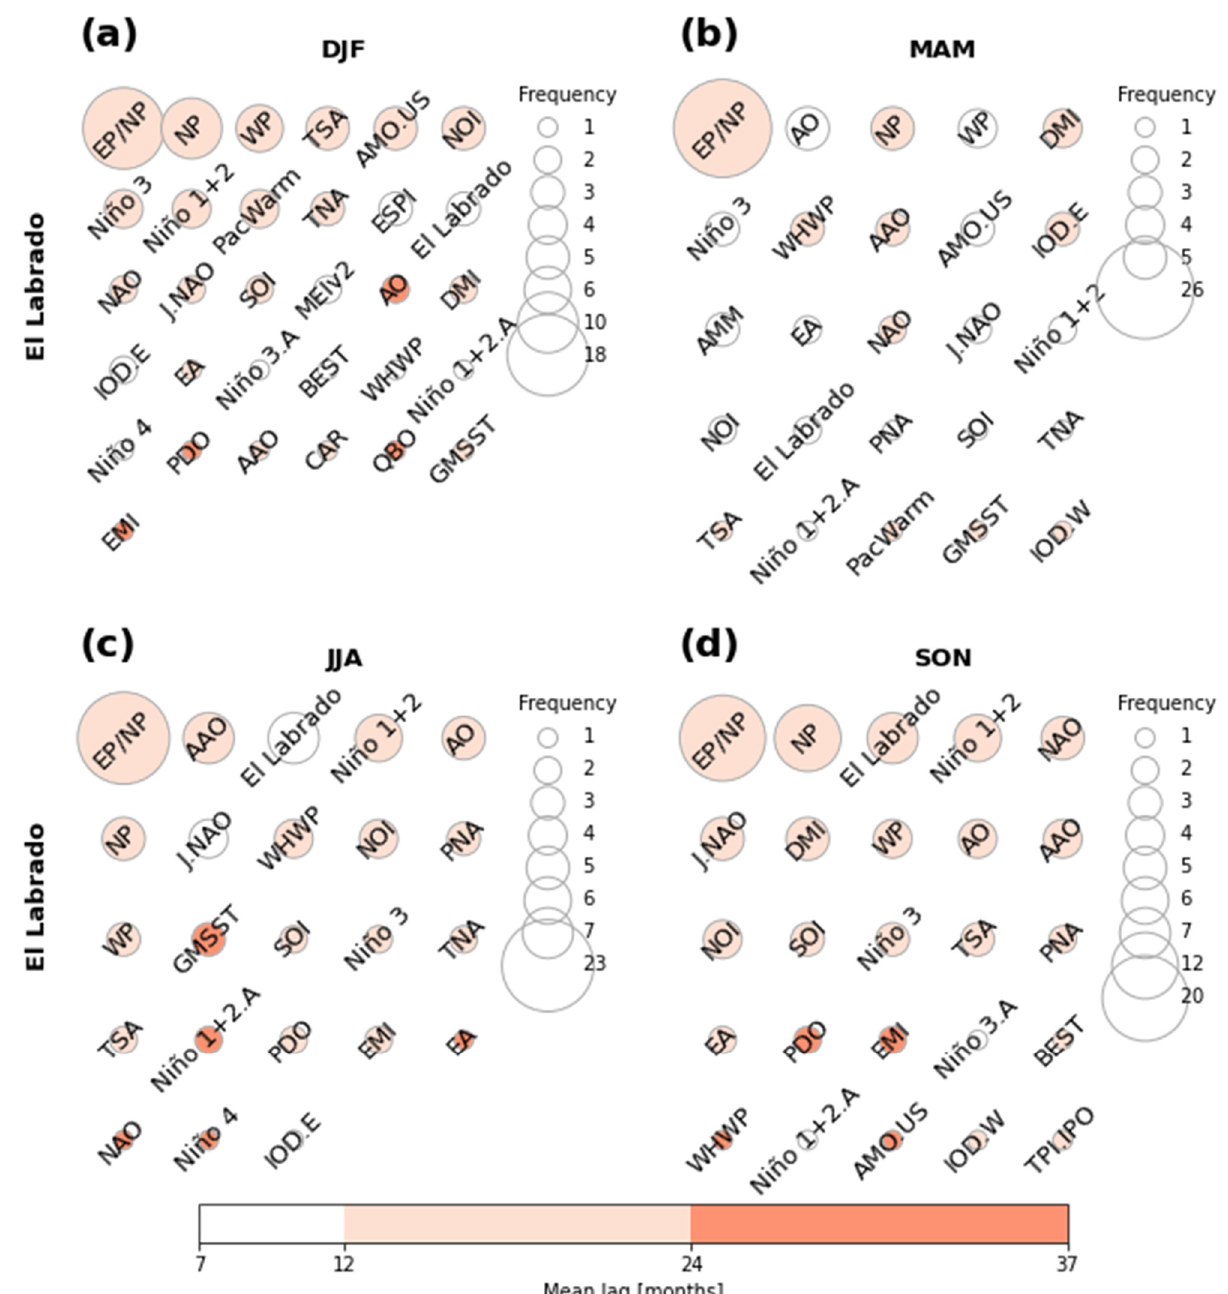
Figure 5. Predictors selected through SFS for each quarterly model for El Labrado (dots in Figure 4a): ( a ) quarter December–February; ( b ) quarter March–May; ( c ) quarter June–August; ( d ) quarter September–November. The size of each circle corresponds to the frequency with which a climate index (with different lags) appears as a predictor of the model. The color of each circle corresponds to the mean of the lags with which a climate index appears as a predictor of the